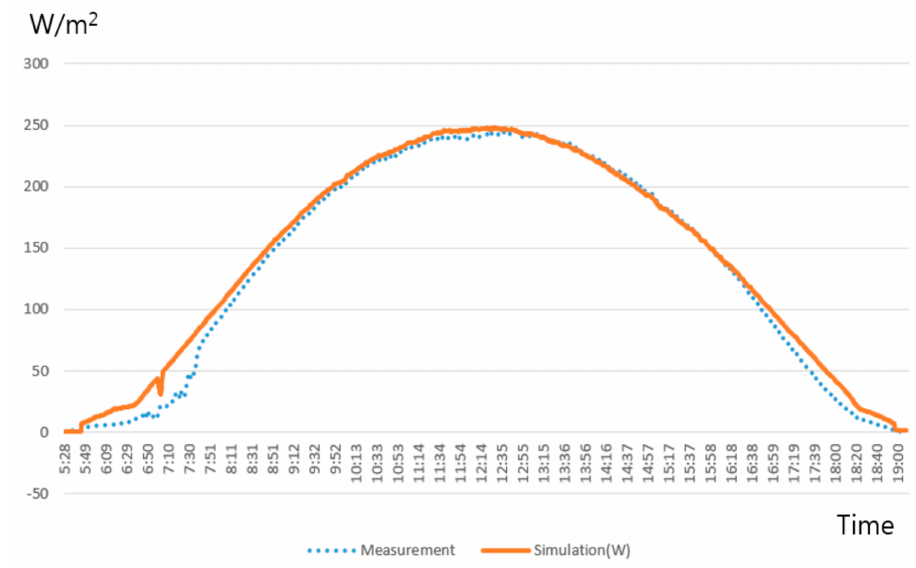
Figure 6. PV module power generation graph showing measurement and prediction (05 May 2015).